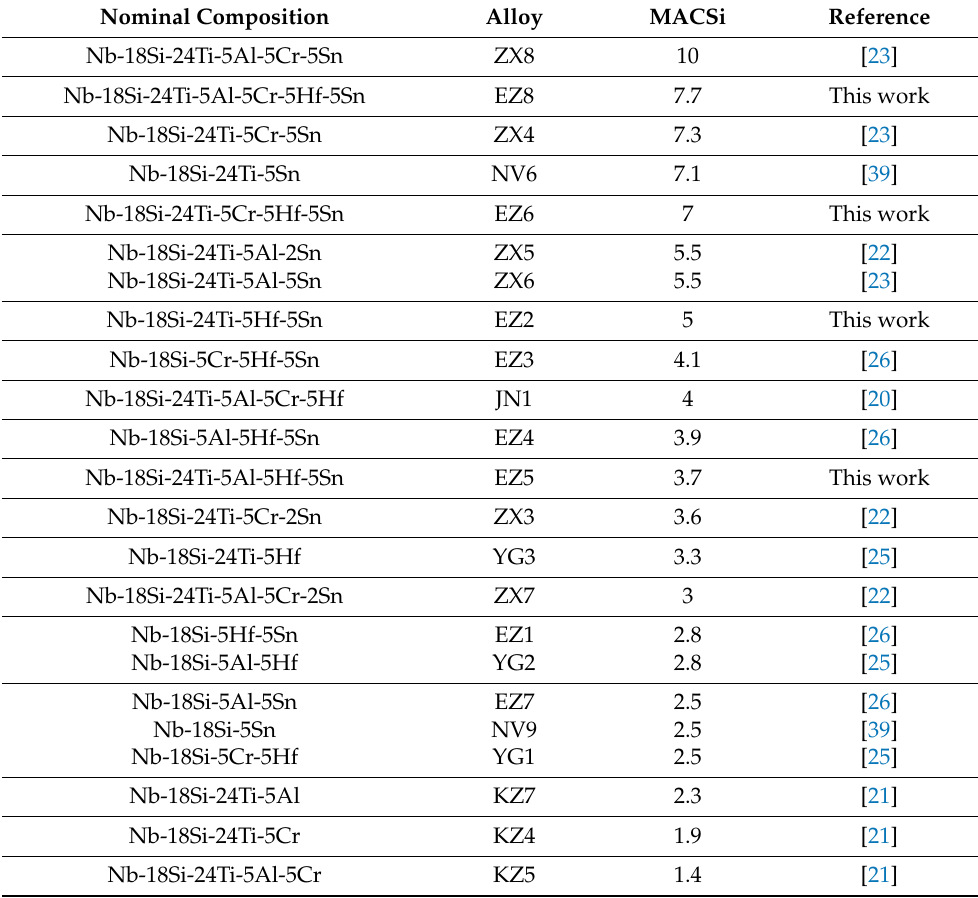
Table 6. Effect of alloying addition(s) (nominal composition, at.%) on the macrosegregation of Si (MACSi = C Si max − C Si min , at.% [40]) in as-cast Nb-18Si silicide-based alloys with/without Ti addition. Nominal Composition Alloy MACSi